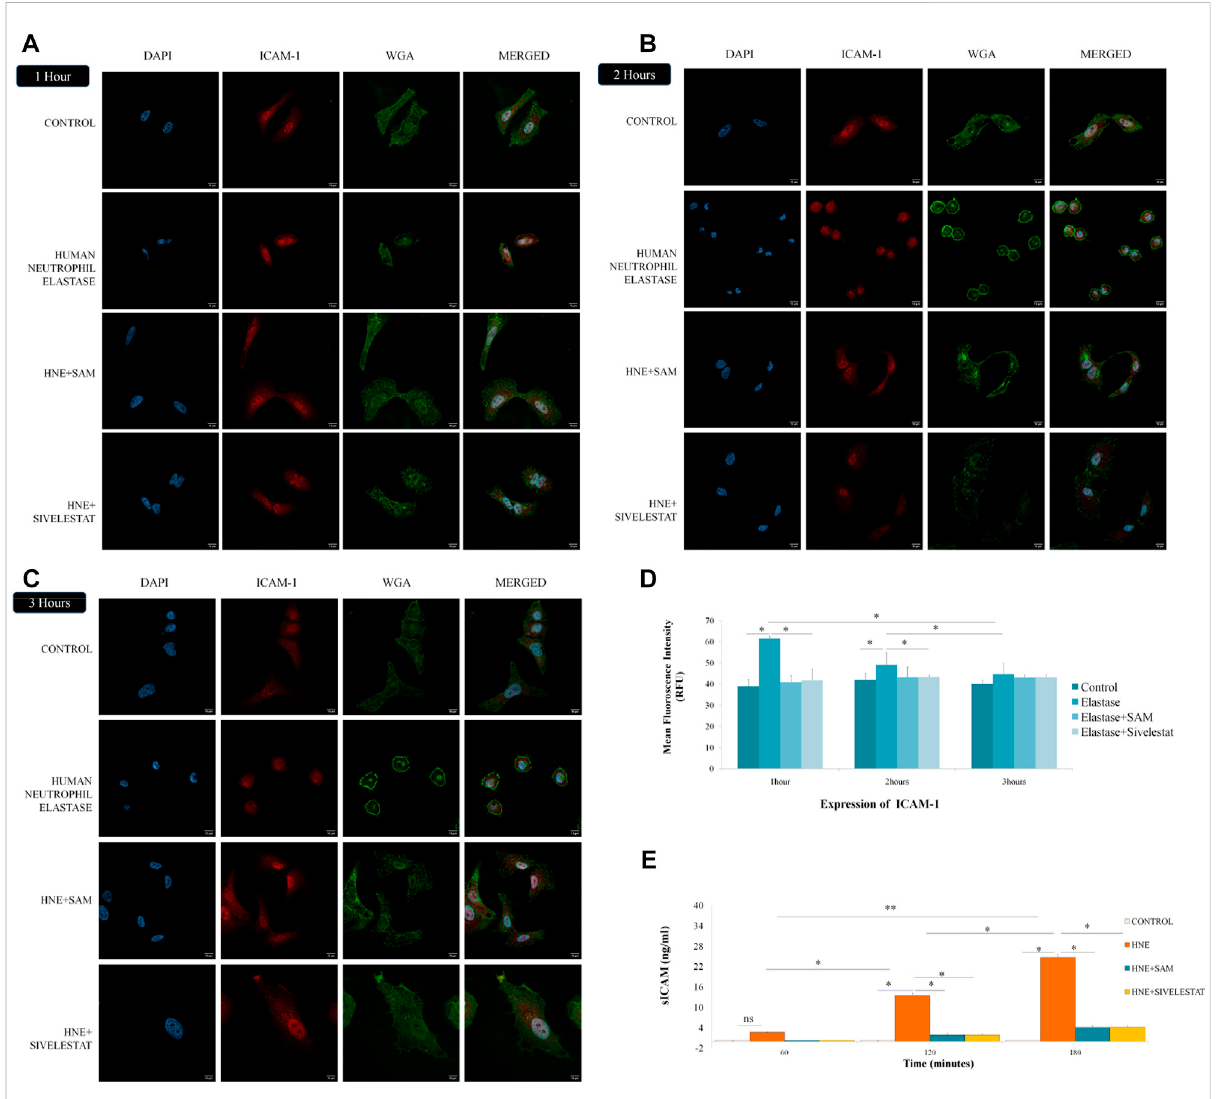
FIGURE 5 S.apetala fruitextracts ameliorates ICAM-1 release inducedby neutrophil elastase in vitro (A) The ICAM-1 expressionin lung epithelial cells was signi fi cantly increasedafter1 hofelastasetreatment. (B) IncreaseinICAM-1expressionafter2 hwithdeformationincellshapewasrestoredinSAM/ Sivelestatgroups. (C) CompleteroundingofelongatedepithelialcellswithincreasedICAM-1expressionreversedbyconcomitanttreatmentofSAM/ Sivelestat (C) as assessed under Confocal microscope at 60× magni fi cation stained with DAPI (blue). anti-ICAM-1 antibody (red), and WGA (green). (D) Mean fl uorescenceintensity (MFI)wascalculatedforICAM-1expressionateachtime point. (E) sICAM levelsweremeasuredafter1,2and 3 h of elastase treatment by ELISA. Signi fi cant increase in sICAM levels were observed after second and third hour which was reversed by treatment with SAM/Sivelestat.